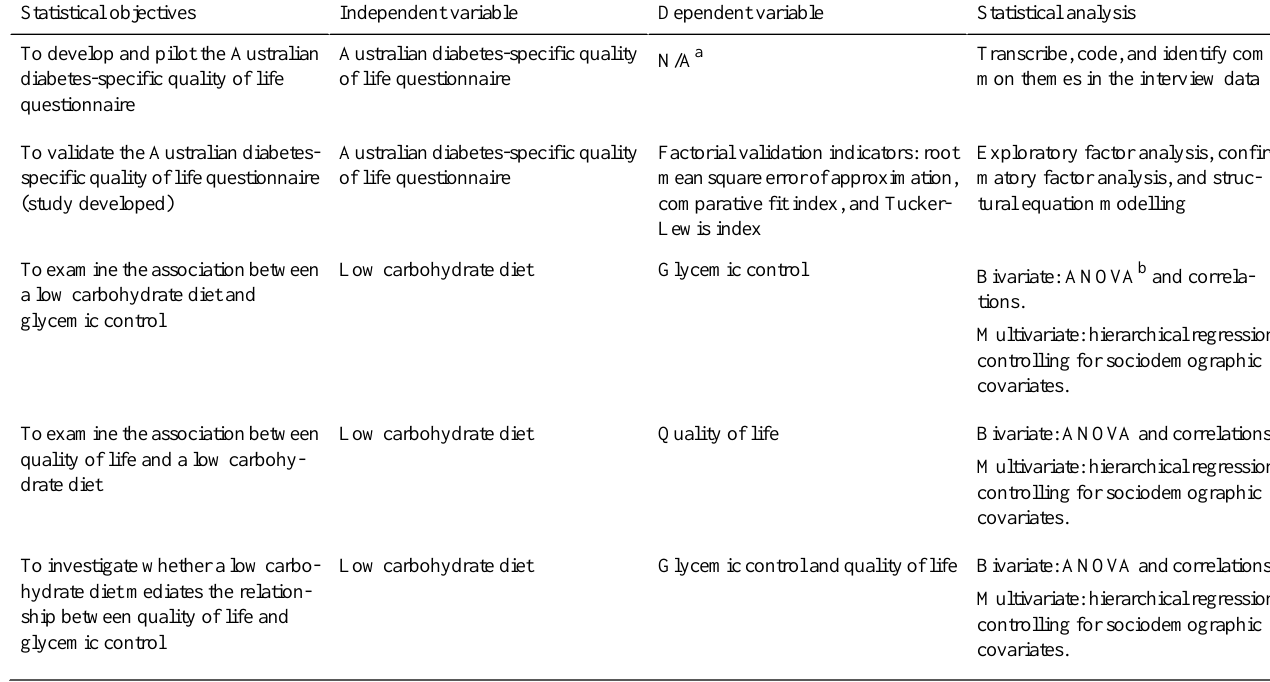
Table 4. Brief statistical